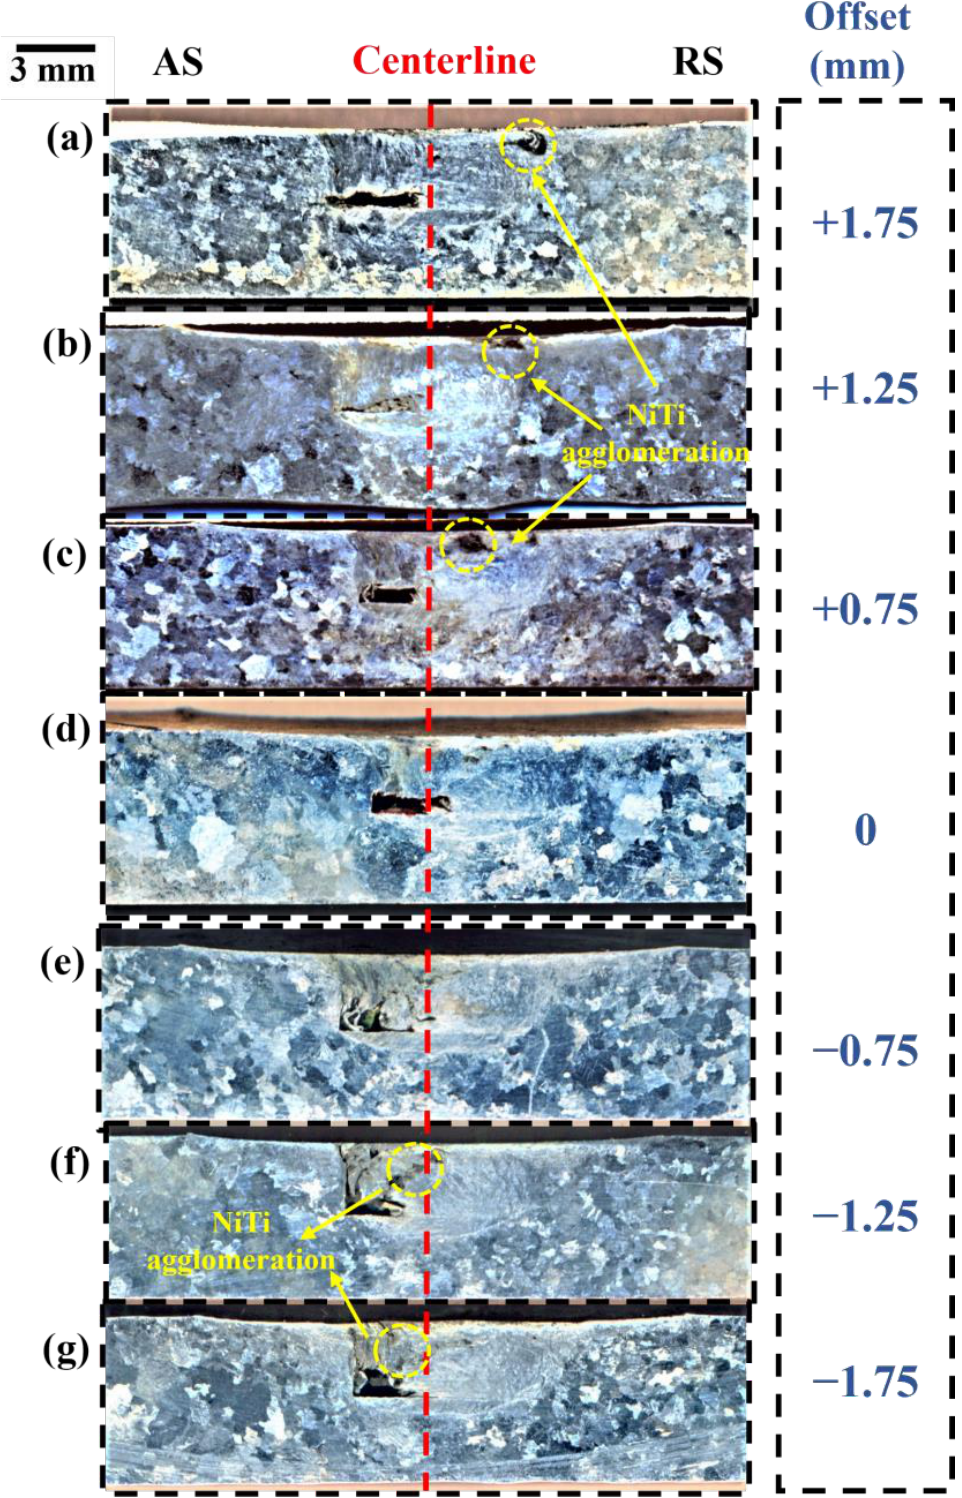
Figure 3. Transverse section macrostructure of the friction stir processed Mg plate at different offset positions: ( a ) +1.75 mm, ( b ) +1.25 mm, ( c ) +0.75 mm, ( d ) 0 mm, ( e ) − 0.75 mm, ( f ) − 1.25 mm, ( g ) − 1.75 mm.